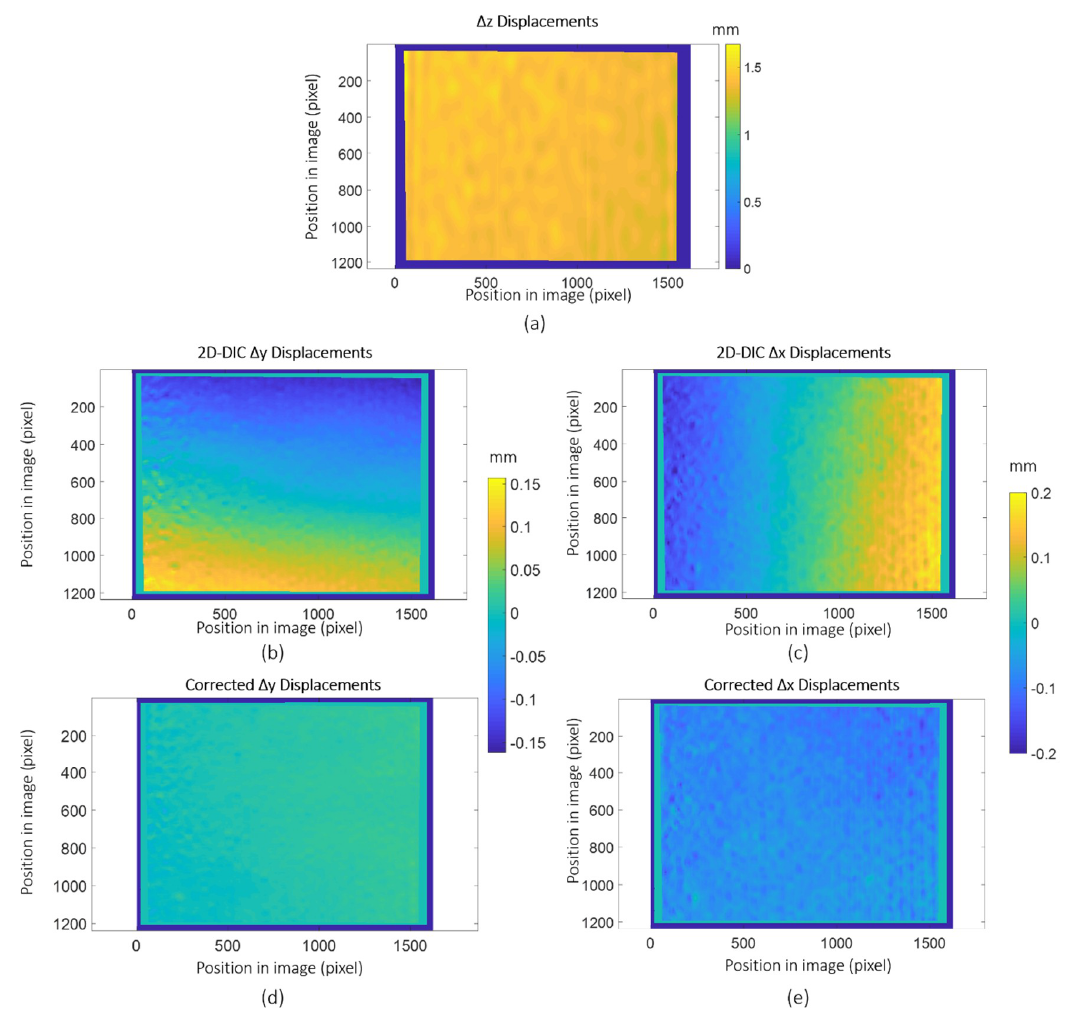
Figure 9. Displacement maps measured with LCD projection and a 3-CCD camera at maximum ∆ z Figure 9 . Displacement maps measured with LCD projection and a 3-CCD camera at maximum Δ z displacement of 1.5 mm. ( a ) ∆ z displacement map ( b ), ( c ) ∆ x and ∆ y displacement map measured by displacement of 1.5 mm. ( a ) Δ z displacement map ( b ), ( c ) Δ x and Δ y displacement map measured by 2D-DIC and ( d ), ( e ) ∆ x and ∆ y corrected displacement map (field of view size 157.5 mm × 119.9 2D-DIC and ( d ), ( e ) Δ x and Δ y corrected displacement map (field of view size 157.5 mm × 119.9 mm).